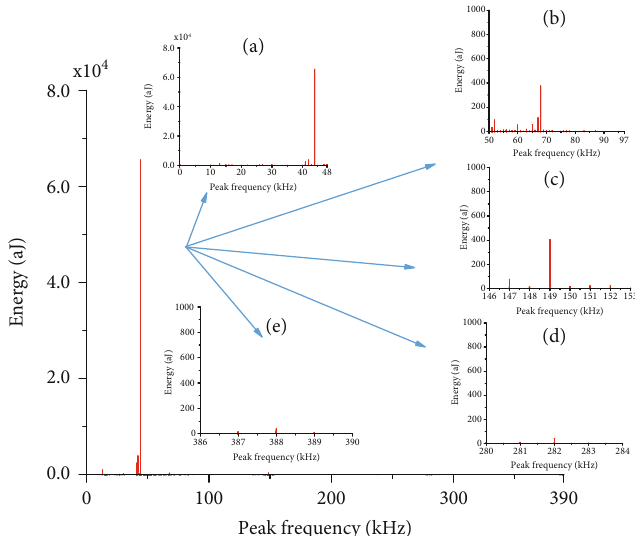
Figure 9: Distribution of AE energy with peak frequency: (a) range 0-48 kHz, (b) range 50-97 kHz, (c) near 149 kHz, (d) around 284kHz, and (e) near 388kHz.